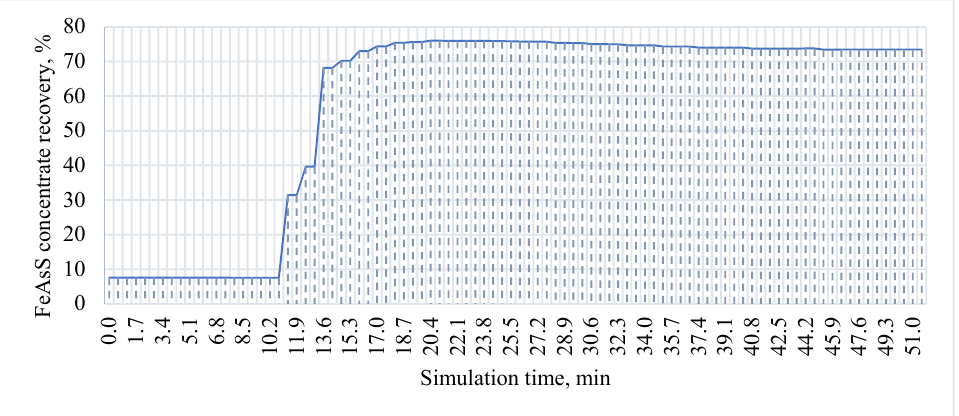
Figure 8 . FeS 2 concentrate grade.